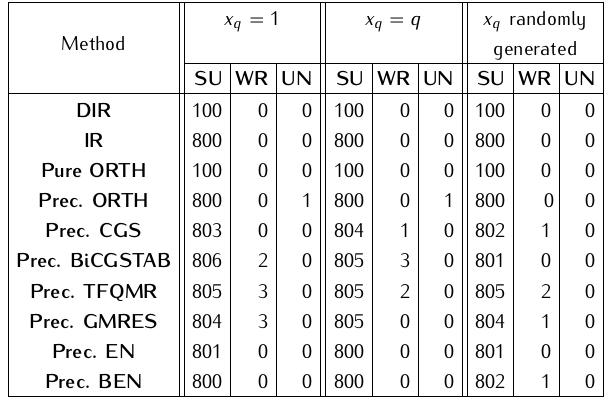
Table 13. The same as Table 12, but low accuracy ( ACCUR